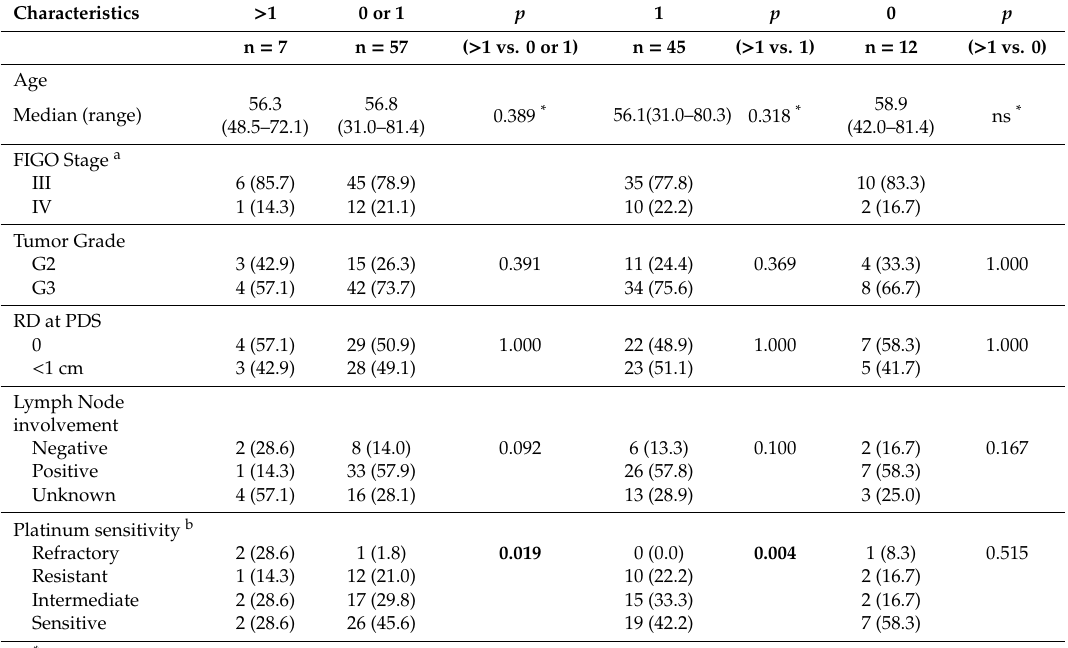
Table 4. Main clinico-pathologic characteristics of patients with HGSOC and number of mutated genes within the panel.